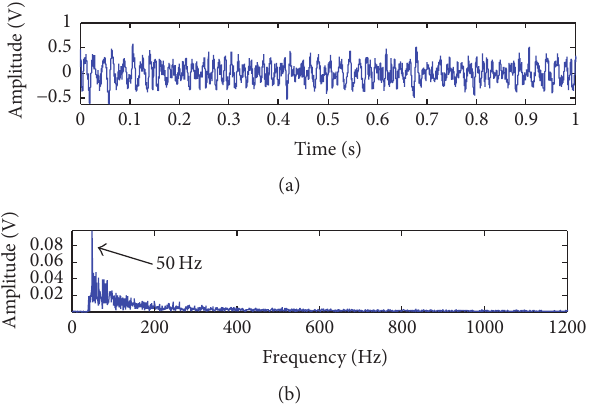
Figure 11: The statistical average of IMFs: (a) time-domain wave- form; (b) frequency spectrum.